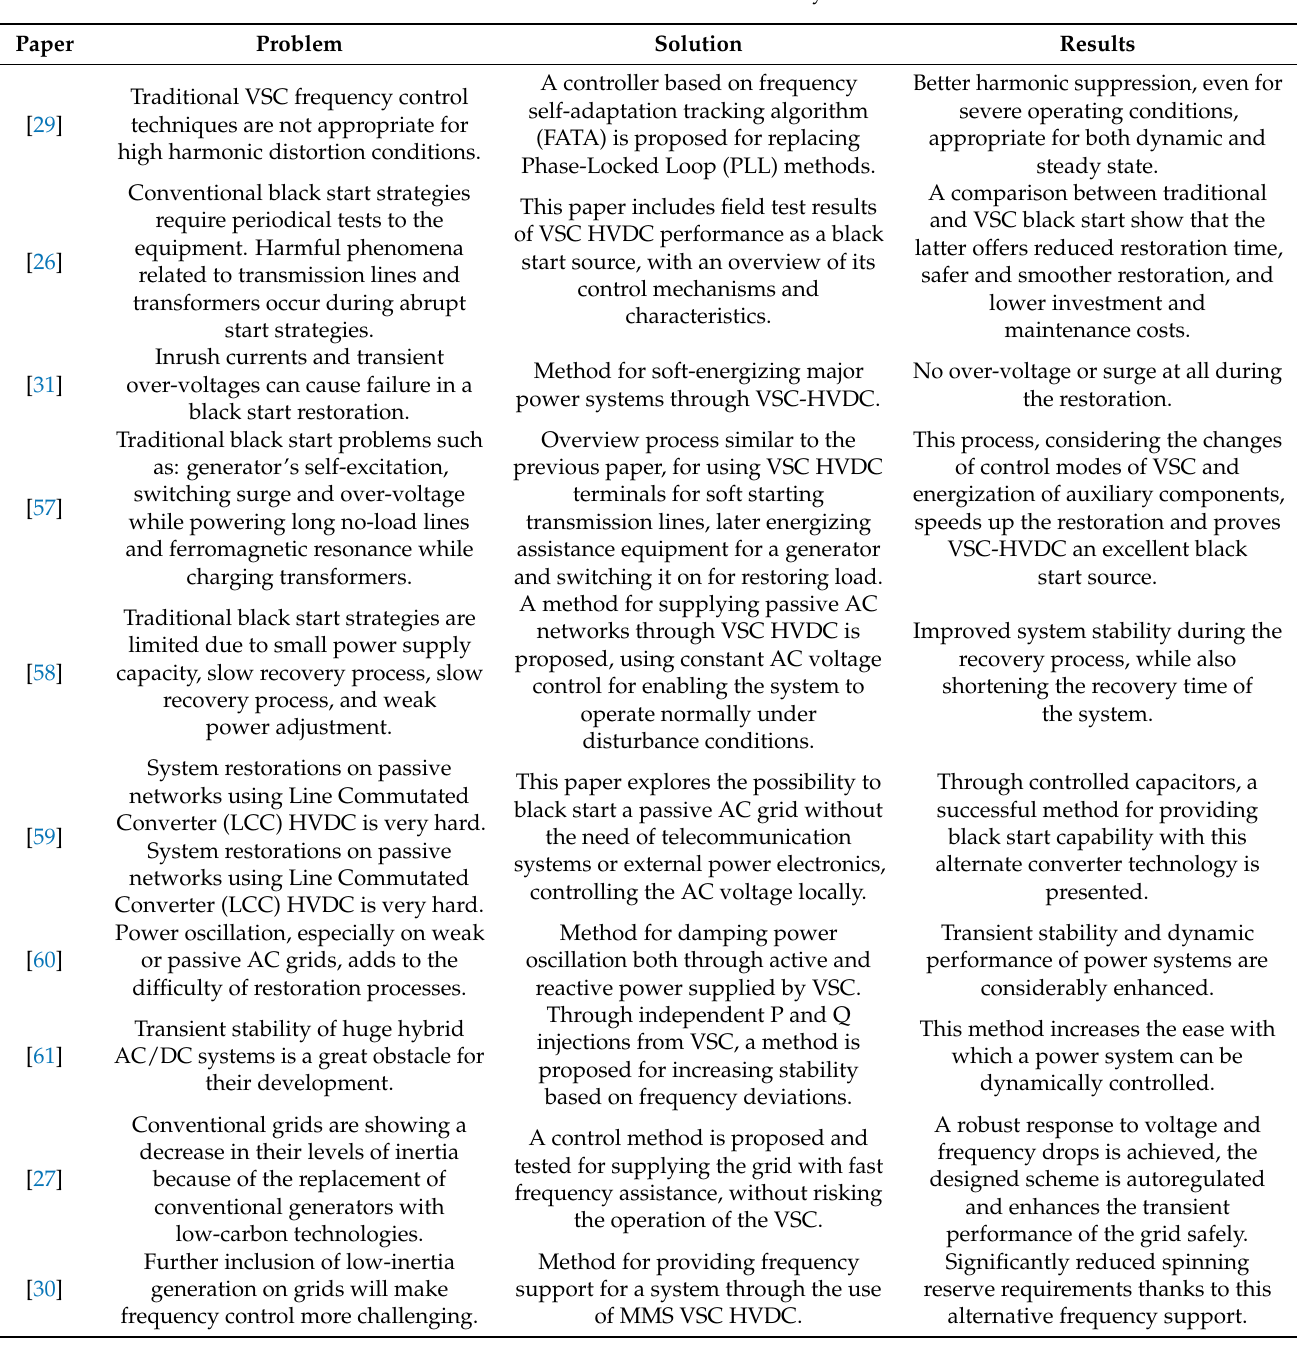
Table 2. Recent VSC solutions to HVDC